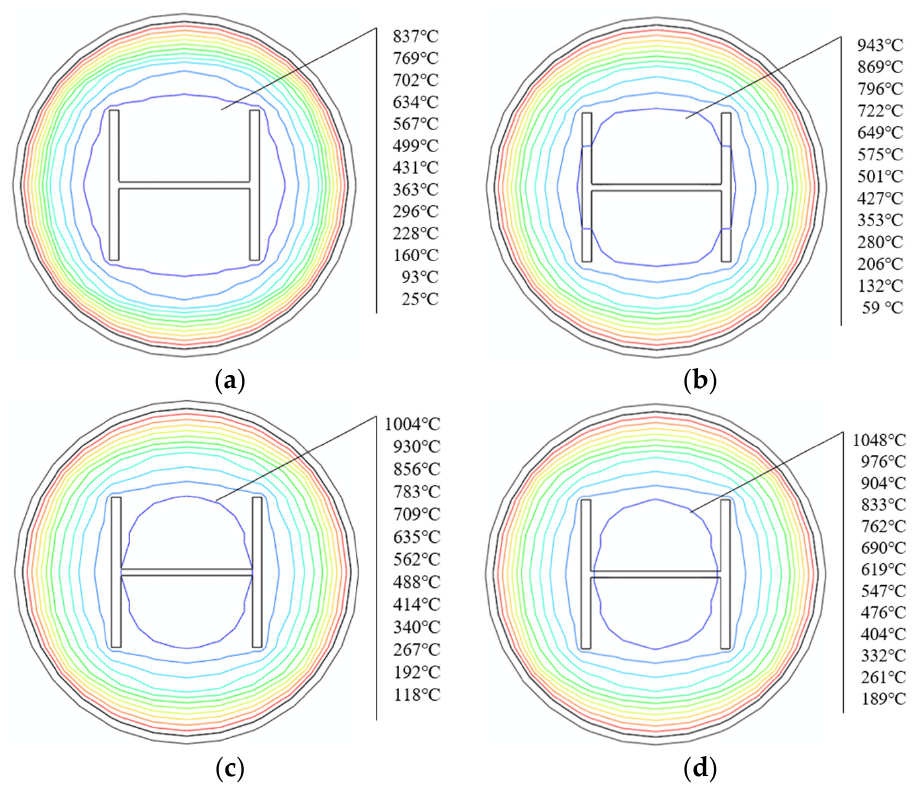
Figure 8. Temperature distribution of section at different times: ( a ) 30 min; ( b ) 60 min; ( c ) 90 min; ( d ) 120 min.